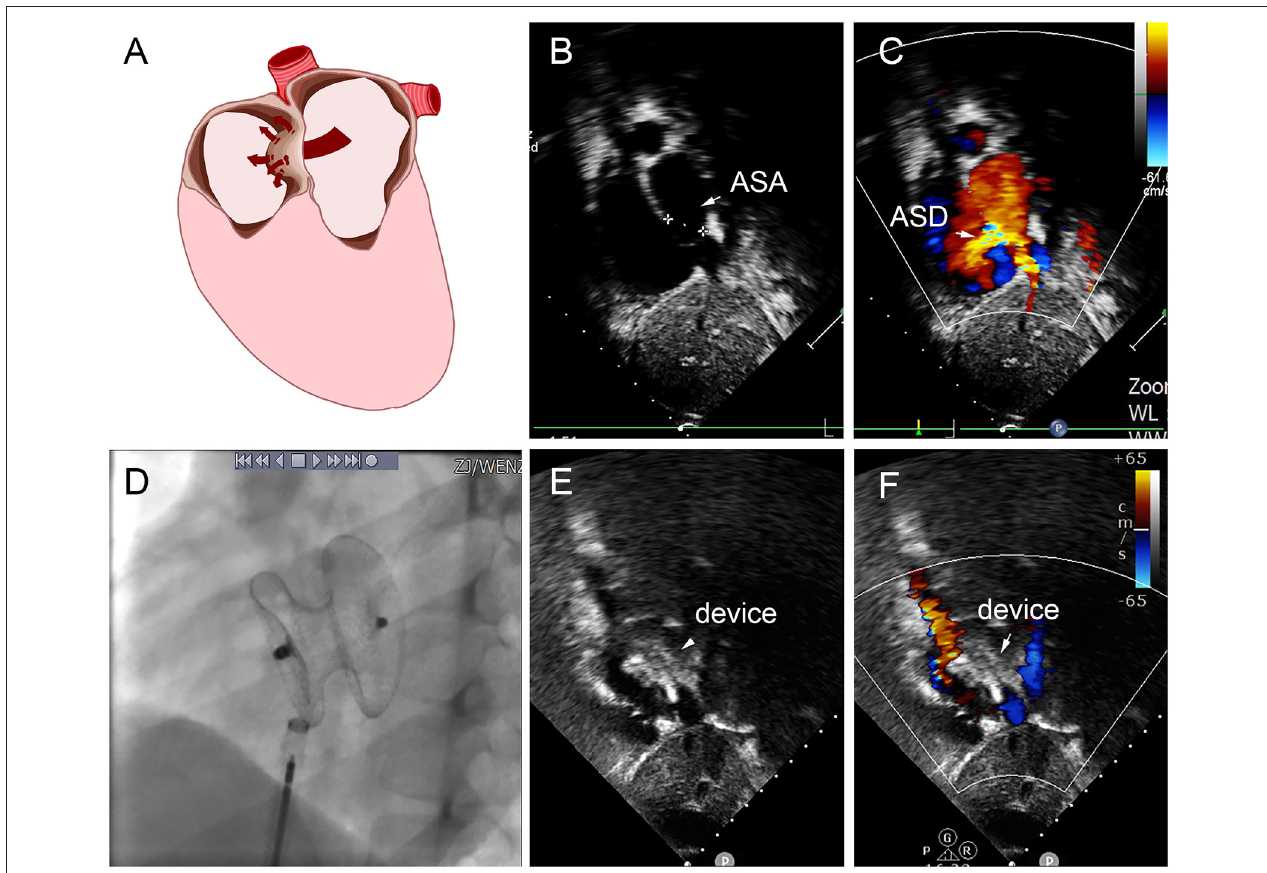
FIGURE 8 | Group E a 8-year-old boy, TTE showed the diameter of aneurysm base was 12mm, with three defects in the aneurysm (8.8mm, 2.5mm, 2.4mm) (A–C) . In the operation, 22 mm MemoPart ASDO implanted the larger defect (D) , and no residual shunt (E,F) and any complication happened from immediate postoperation to last follow-up. ASD, atrial septal defect; ASA, atrial septal aneurysm.